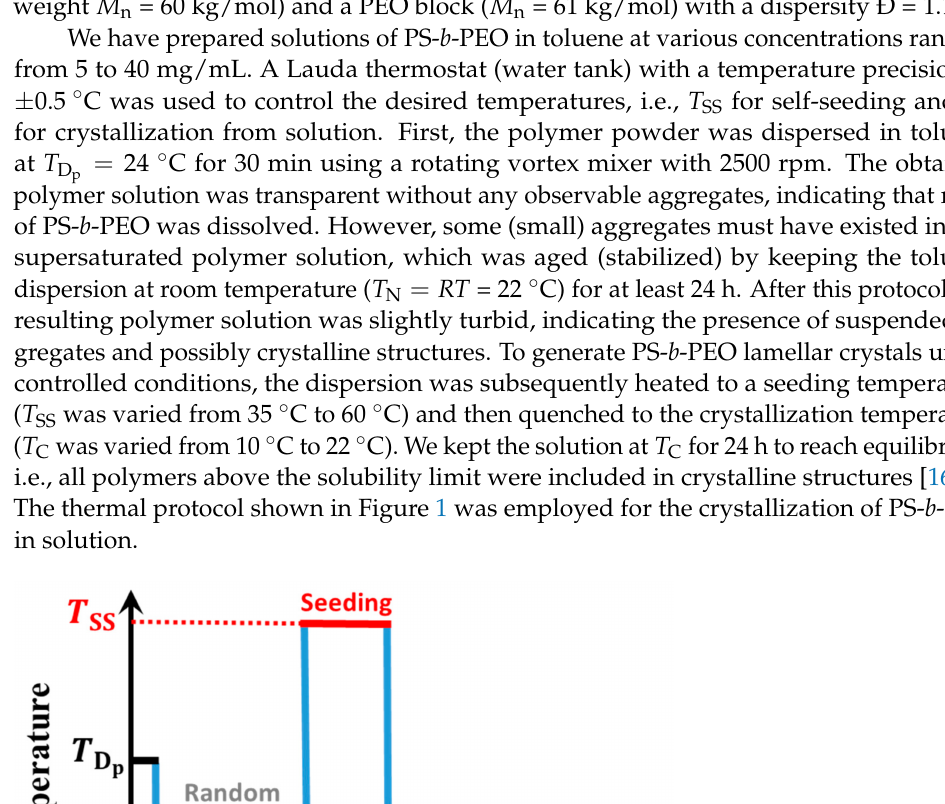
), high nucleation probability and p